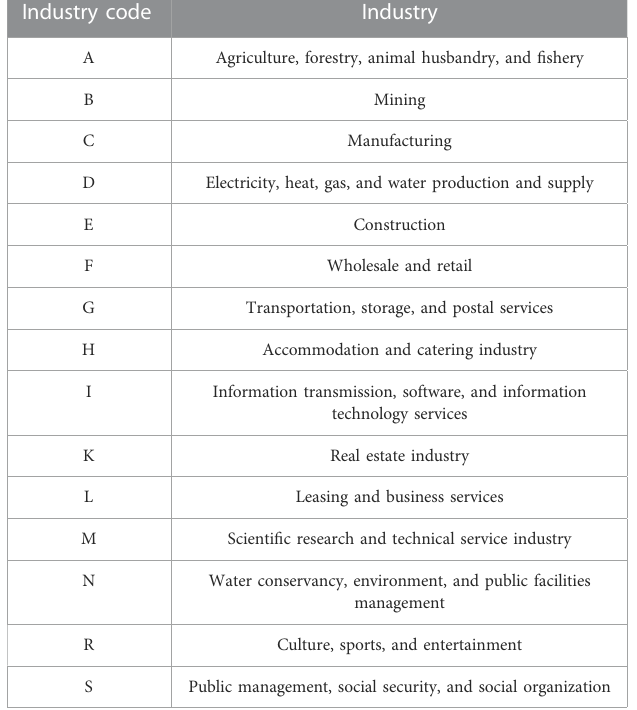
TABLE A1 Industry classi fi cation corresponding to the industry code. Industry code